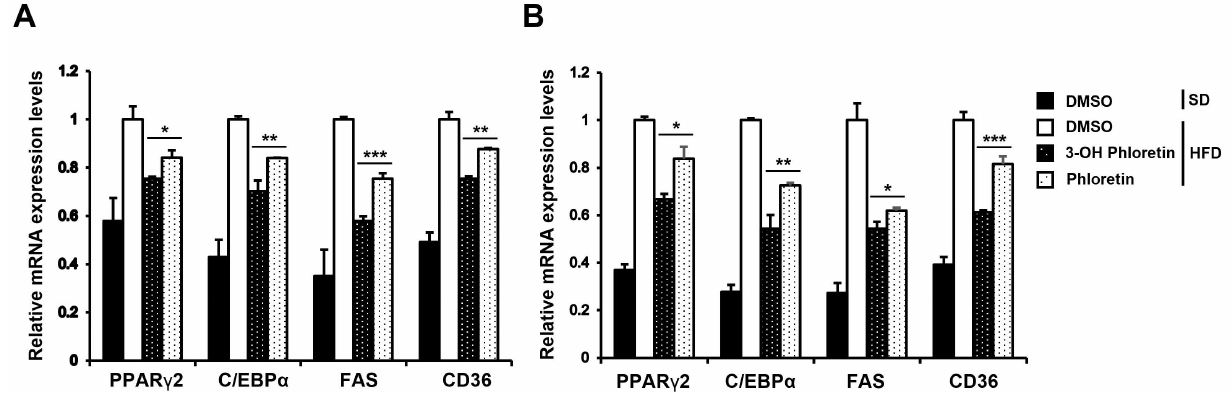
Figure 5. 3-OH phloretin suppressed HFD-induced overexpression of adipogenesis regulators. ( A , B ) The gene expression of PPAR γ 2, C/EBP α , FAS, and CD36 was analyzed in the GWAT and liver using real-time PCR. The data shown are representative of eight independent experiments, and the error bars indicate the mean ± SEM (* p < 0.05, ** p < 0.01, *** p <